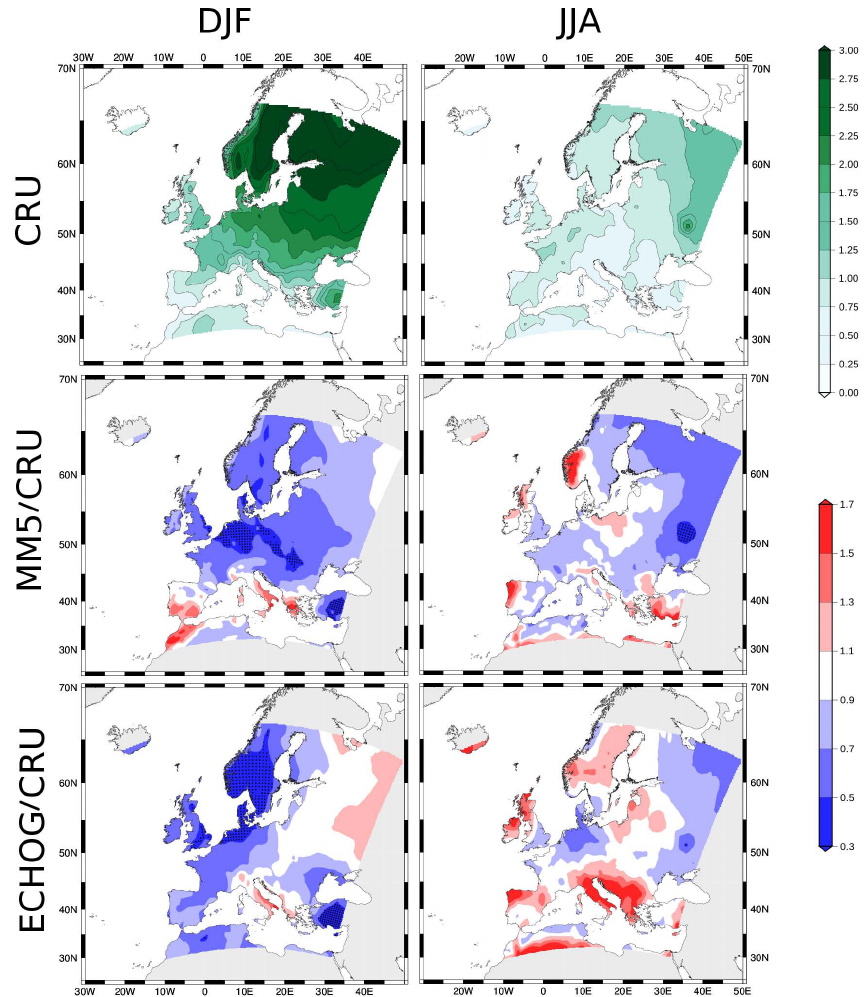
Fig. 6. Standard deviation of seasonal SAT series (in ◦ C) for the 1960–1990 period in winter (left panels) and summer (right panels) in CRU (top panels). Panels below show the ratio between MM5 driven by ECHO-G and CRU (middle panels) and ECHO-G alone and CRU (bottom panels). To perform the calculations, all datasets are spatially interpolated onto the MM5 grid, and only non-ocean grid cells are considered. The significance of the ratio is tested through a two-tailed F test at the 95% confidence level and it is indicated with small black circles in the